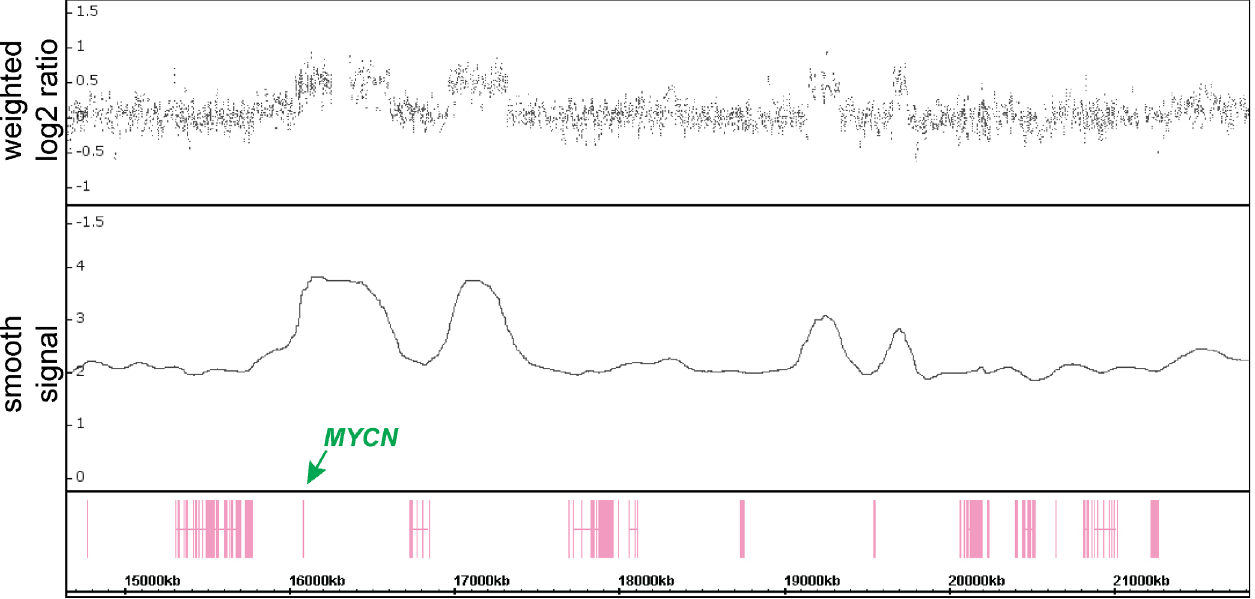
Fig 5. 2p copy number analysis of NB02. This SNP array profile shows a part of chromosome 2 (approx. 15 – 22 Mb). In the upper track the weighted log2 ratios, in the middle track the smoothed copy number signals and in the lower track the spatial position of annotated genes along the chromosome are shown. The smoothed copy number profile shows four peaks (representing the amplicon) with an average smoothed signal of approx. 3.5 copies including the MYCN gene. The co-amplified regions contain no annotated genes.